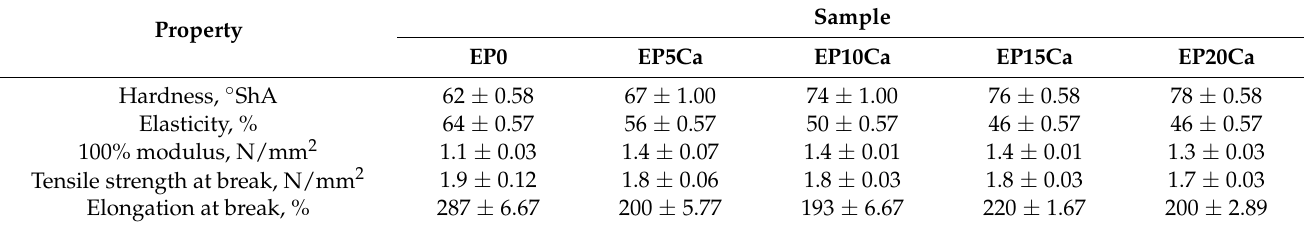
Table 2. Mechanical properties of the EPDM/hemp fiber composites.